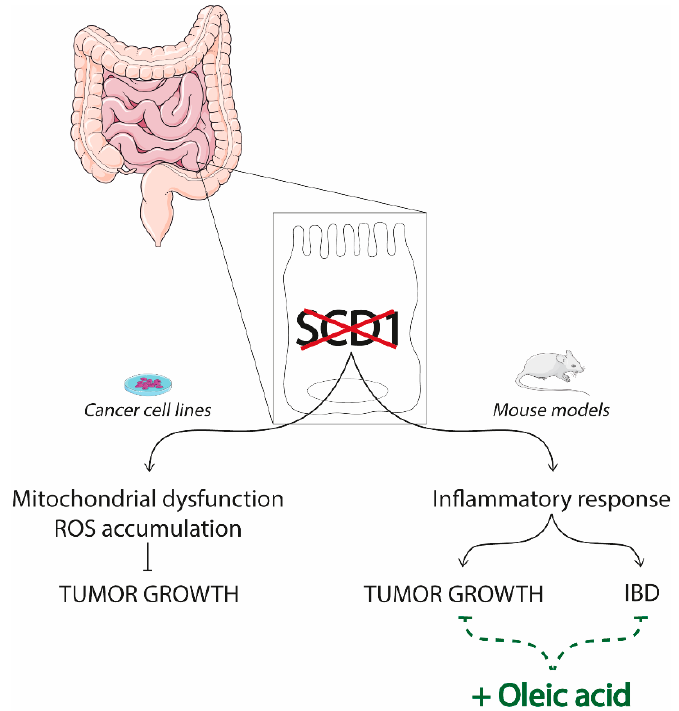
Figure 4. SCD1 inhibition in gut disorders. stearoyl CoA desaturase 1 (SCD1) suppression in intestinal cells offers a divergent scenario. Studies conducted in cancer cell lines indicated that SCD1 suppression inhibits tumor growth by increasing mitochondrial dysfunction and reactive oxygen species (ROS) accumulation. On the other side, investigations carried out using mouse models, demonstrated that the loss of SCD1 promotes an inflammatory state that worsens inflammatory bowel disease (IBD) as well as cancer growth and progression. Intriguingly, the consumption of oleic acid enriched diet reverses the disease phenotype.